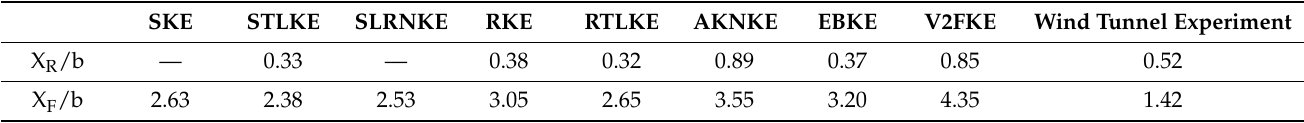
Figure 8. Schematic diagram of XR and XF. Table 3. Calculation results of each turbulence